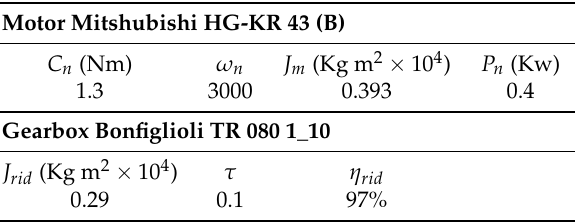
Table 2. Motor and gearbox